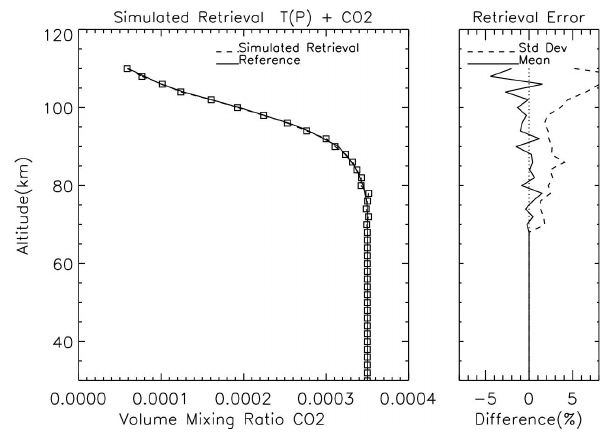
Fig. 22. Same as Fig. 21 but retrieved CO 2 mixing ratio profile.